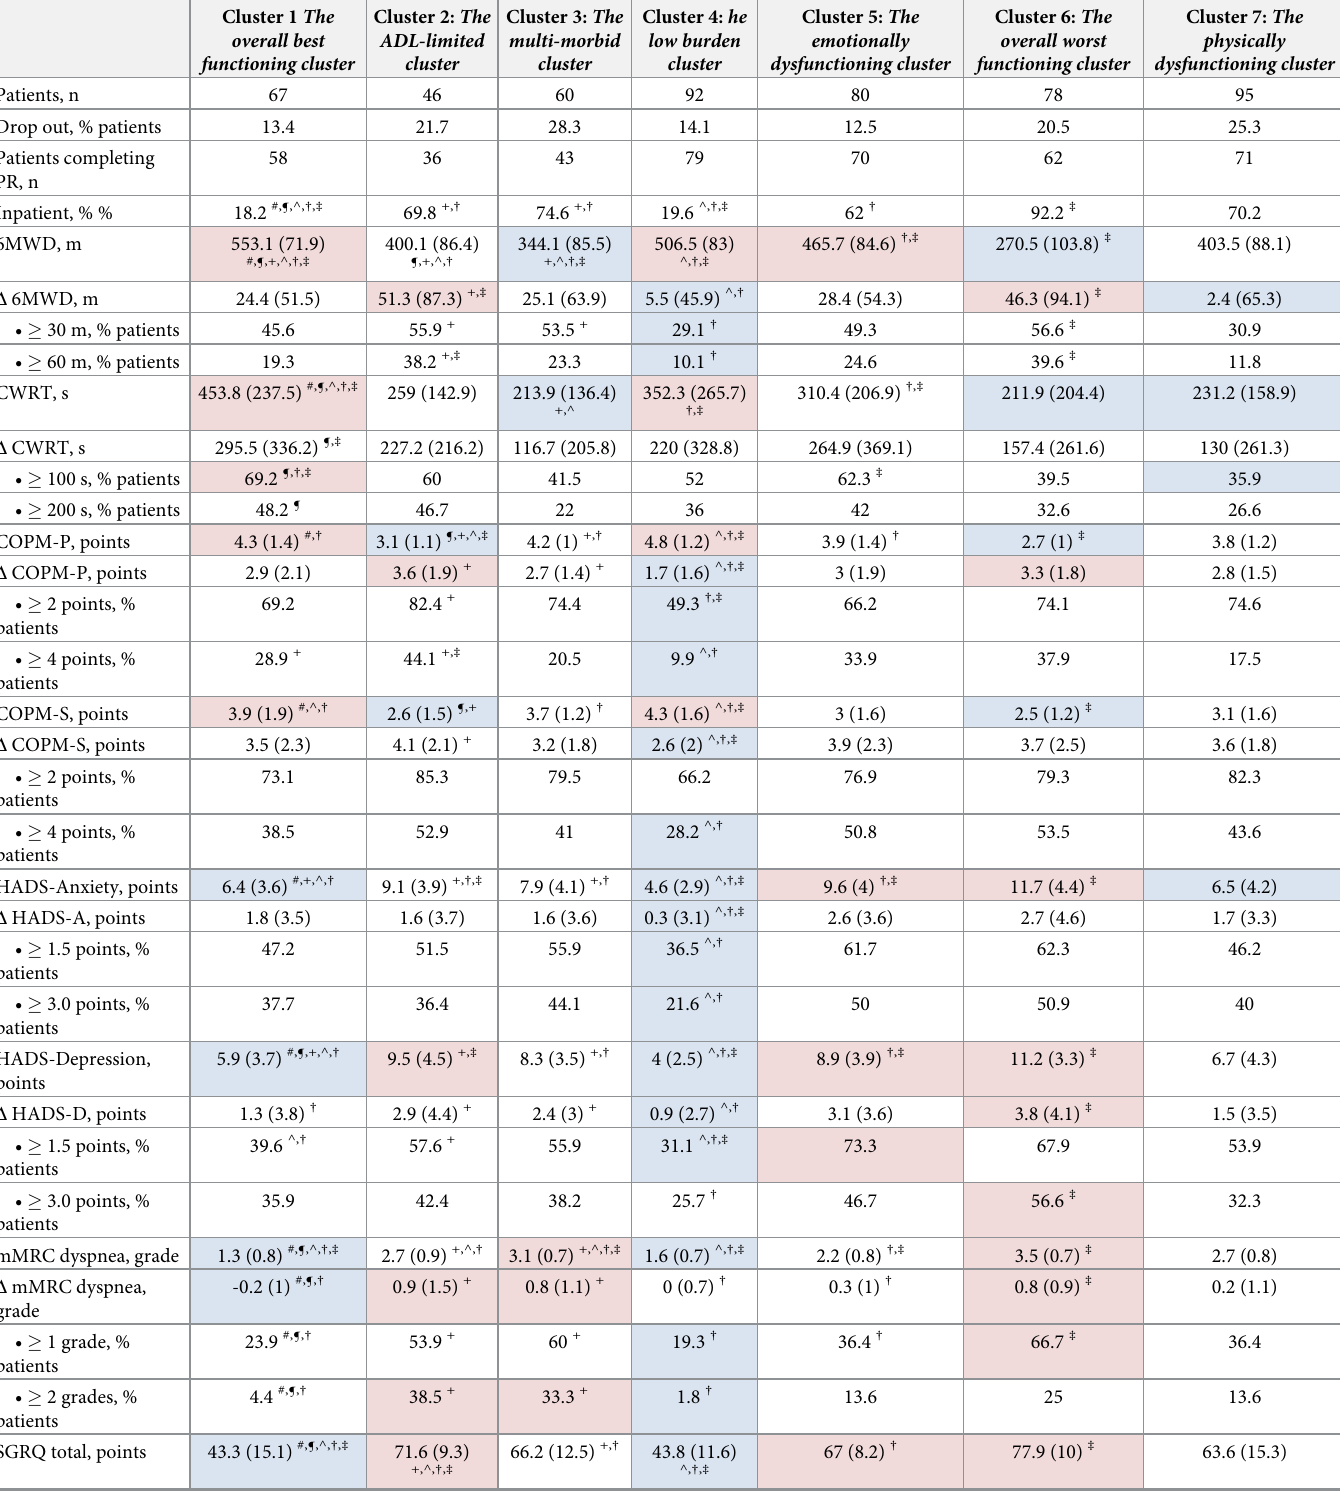
Table 4. Responses to pulmonary rehabilitation for the seven